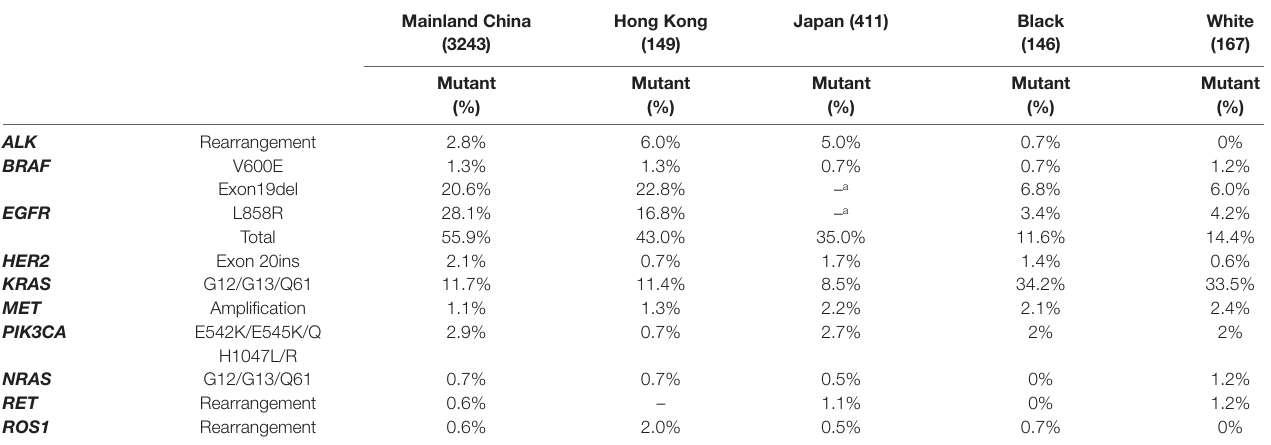
TaBLE 2 | Comparison of driver gene mutations of lung adenocarcinoma between mainland China (this study), Hong Kong (Diehl et al., 2008), Japan (Madic et al., 2012), Black, and White (George et al.,